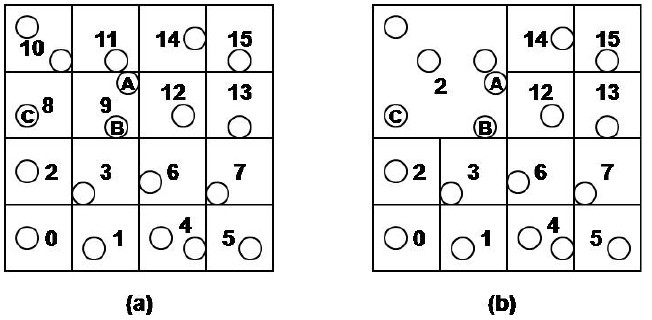
Figure 4. Merge operation for handling